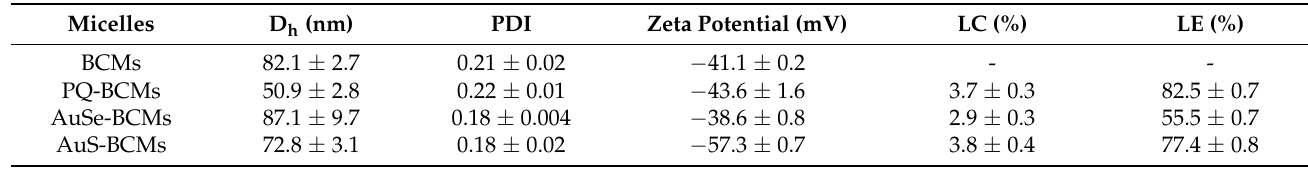
Table 1. Hydrodynamic diameter (D h ), Polydispersity index (PDI), Zeta Potential, Loading Content (LC), and Loading Efficiency (LE) of micelles.